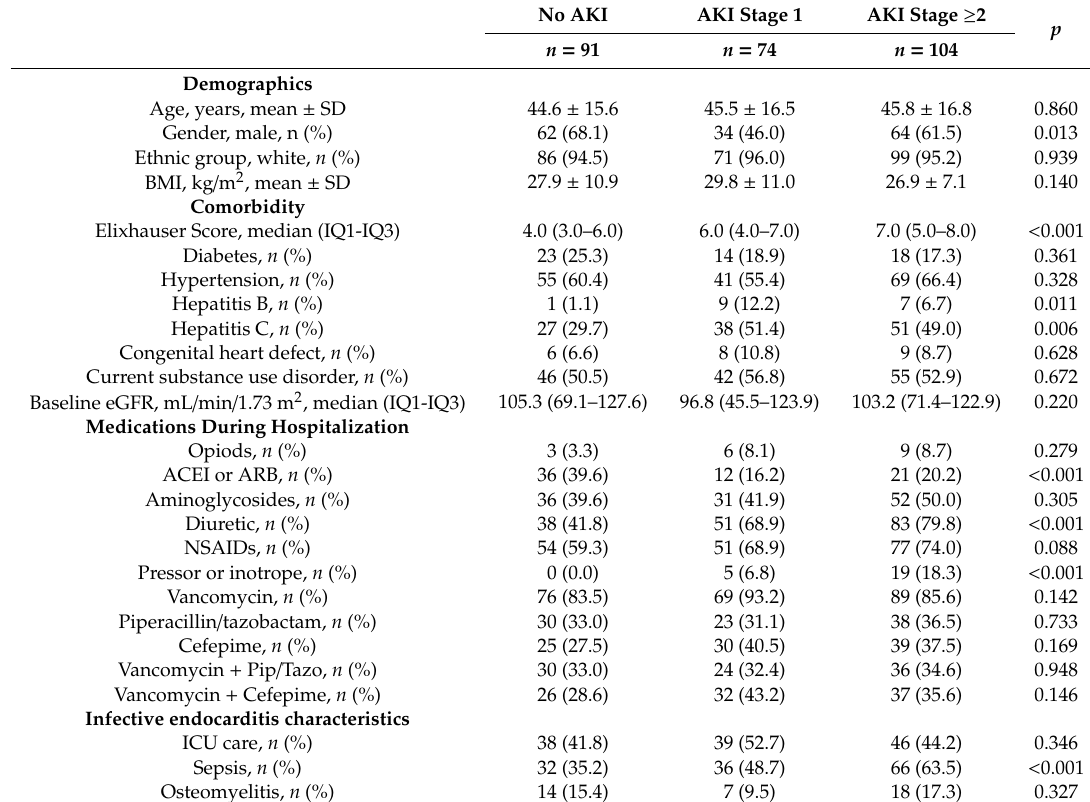
Figure 1. Cohort derivation. Abbreviations: AKI (acute kidney injury), eGFR (estimated glomerular filtration rate), ESRD (end-stage renal disease), IE (infective endocarditis). Table 1. Patient characteristics according to acute kidney injury